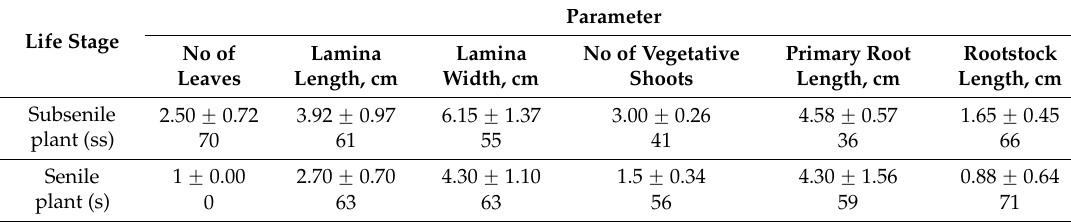
Table 4. Morphological characteristics of old individuals (ss, s) of Anemone patens ( n = 10 for each life stage). In the numerator is the mean ( ¯ X ) and its standard error ( ˘ SE ), and in the denominator the coefficient of variation (% CV